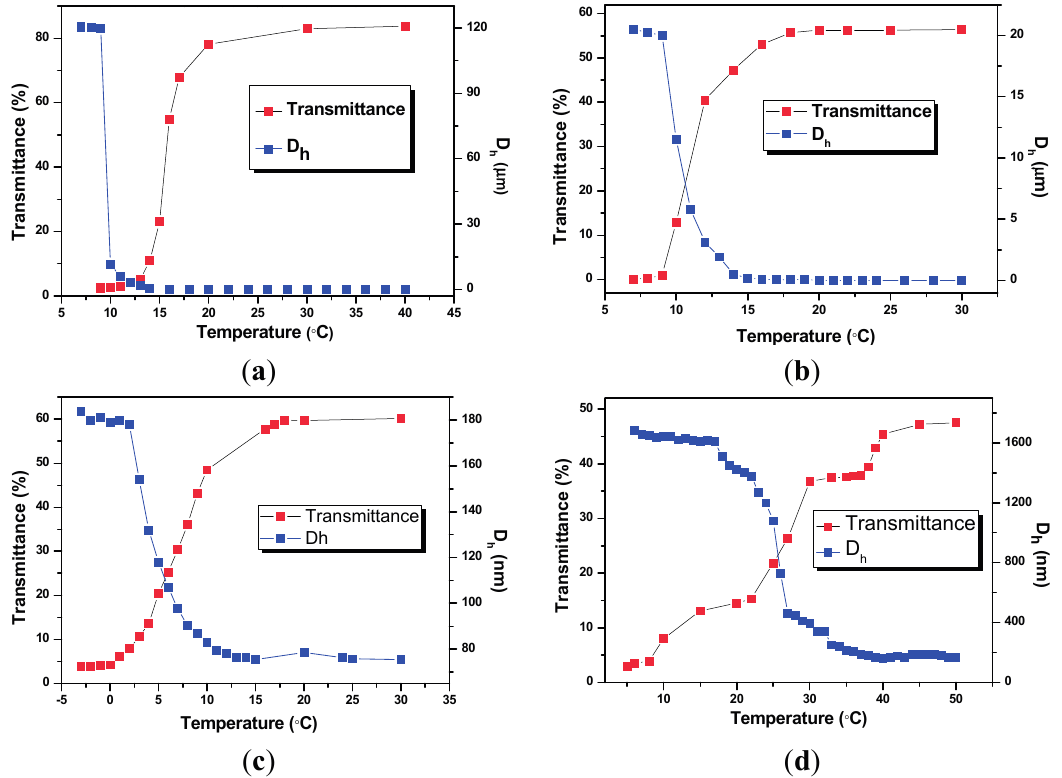
Figure 5. Temperature dependence of transmittance at 500 nm and hydrodynamic diameters (D h ) for 5 wt % nanogel in methanol. (( a ) [C 6 VIm]Br:EGDMA = 5:1; ( b ) [C 6 VIm]Br:EGDMA = 10:1; ( c ) [C 6 VIm]Br : DVB = 3:1; ( d ) [C 6 VIm]Br:DVB =